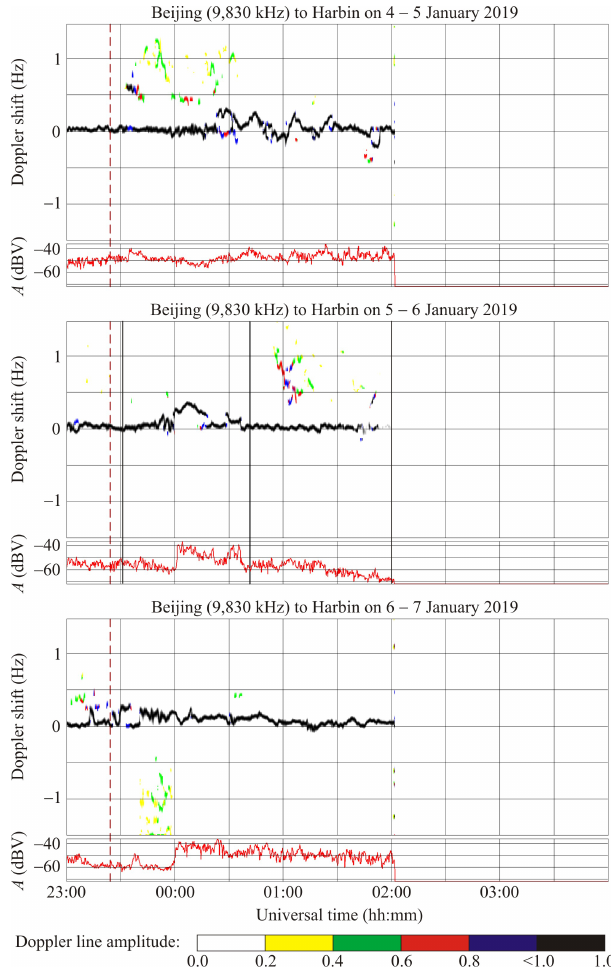
Figure 9. The same as in Fig. 4 but for the Beijing to Harbin radio- wave propagation path.